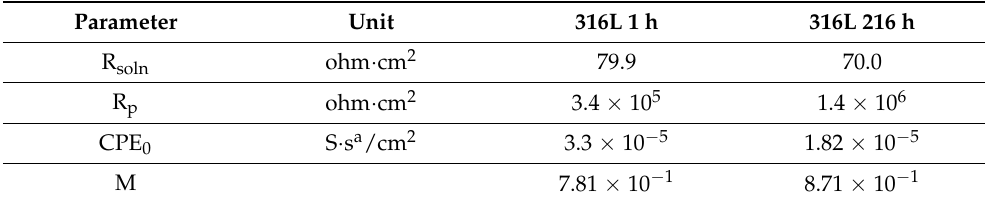
Table 5. EIS fitting parameter of AISI 316L after 1 h and 216 h of immersion in a Ringer’s solution at 37.5 ◦ C.